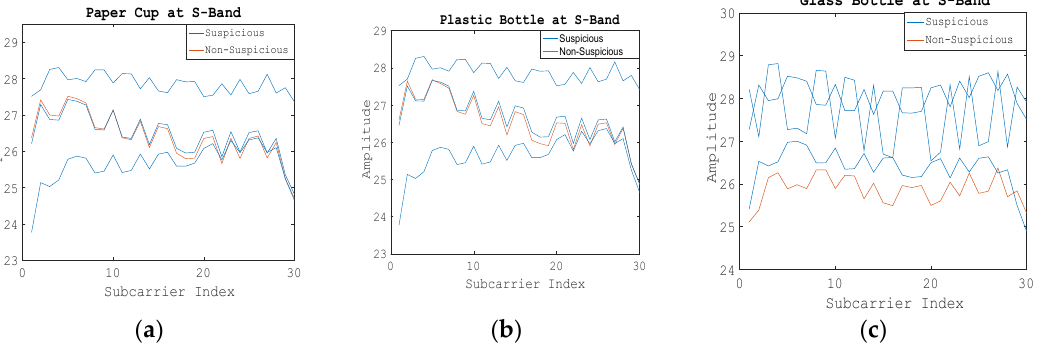
Figure 4. Amplitude information of 30 subcarriers of Step 1 at the C-band. ( a ) Using the paper cup; ( b ) Using the plastic bottle; ( c ) Using the glass bottle. The conclusion of the S-band was the same, as shown in Figure 5.